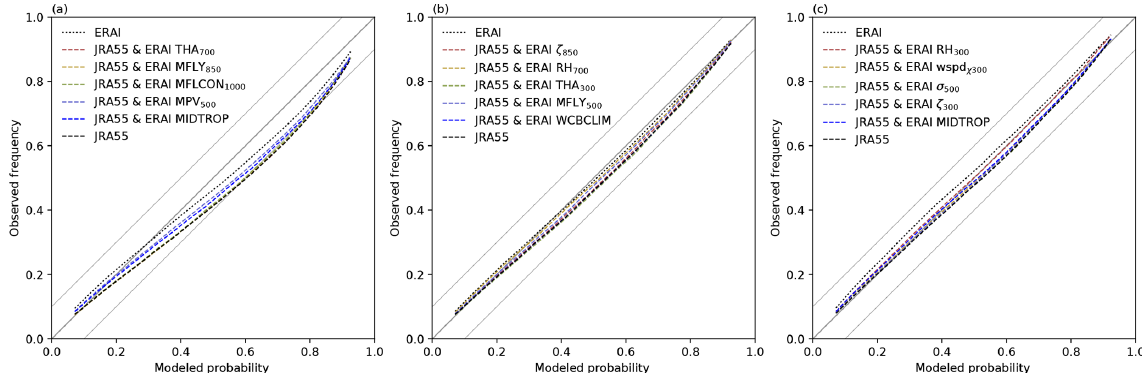
Figure 3. Reliability diagrams of the CNN models for (a) WCB inflow, (b) WCB ascent, and (c) WCB outflow when being applied to ERA- Interim (dotted black line) and JRA55 (dashed black line). Colored dashed lines show the reliability for sensitivity experiments outlined in the main text. Please see Table 1 in Part 1 for the abbreviations of predictors. Probabilities modeled with the CNN models ( x axis) and observed frequencies from the trajectory-based dataset ( y axis) are binned into 19 bins based on the modeled probabilities. The perfect modeled probability and a ± 10% interval about the perfect model are shown by the solid